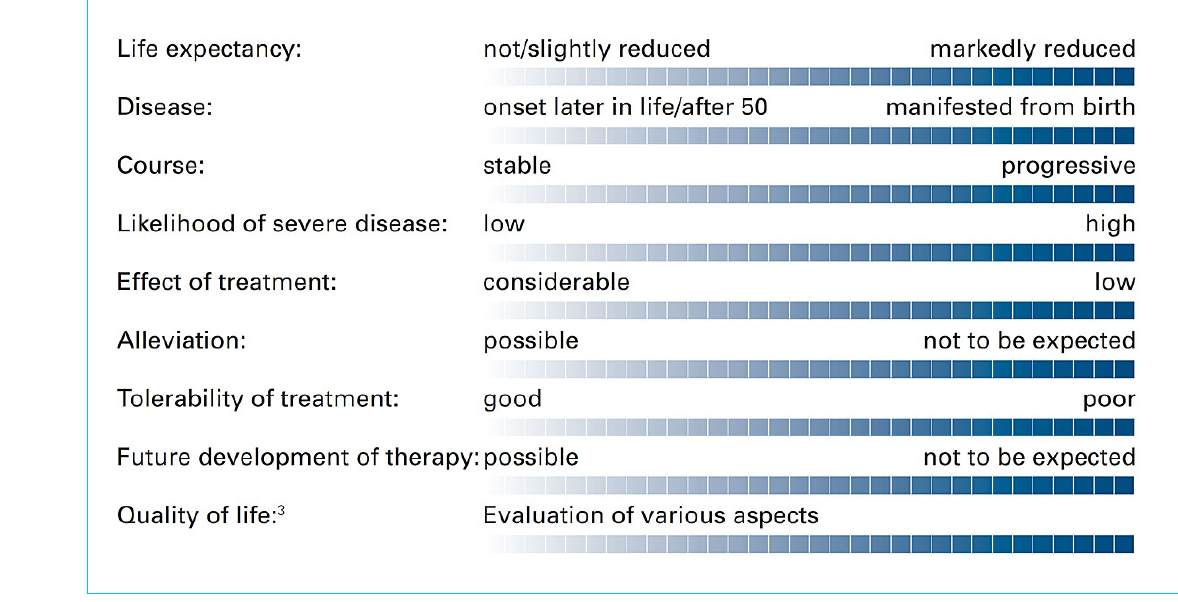
Figure 1: Dimensions for an evaluation of the disease in